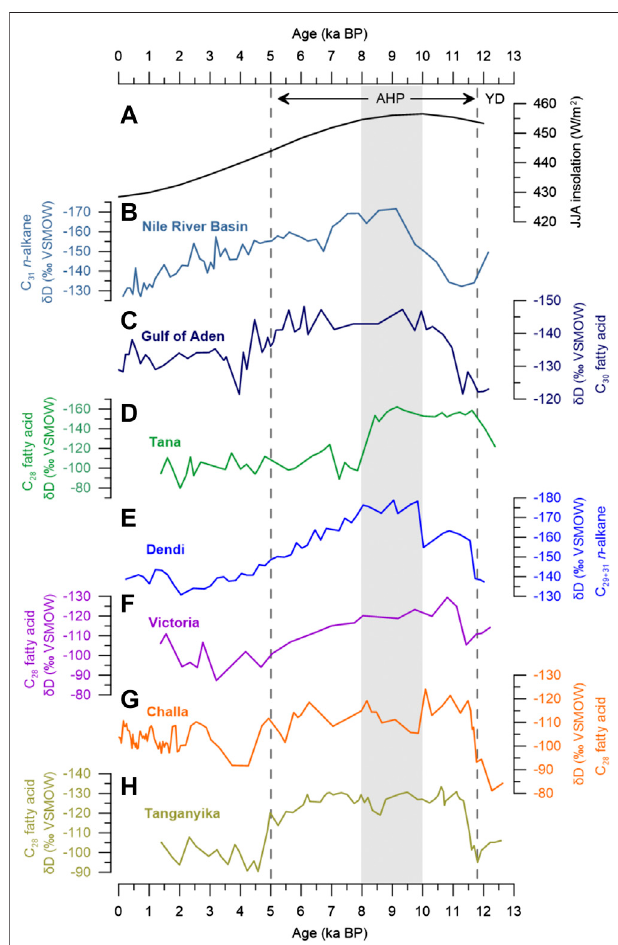
FIGURE 6 | Comparison with other East African δ D wax records. (A) Mean JJA insolation at 10 ° N (Berger and Loutre, 1991). (B) Nile River Basin (Castañeda et al., 2016). (C) Gulf of Aden (Tierney and deMenocal, 2013). (D) Lake Tana (Costa et al., 2014). (E) Lake Dendi (this study). (F) Lake Victoria (Berke et al., 2012b). (G) Lake Challa (Tierney et al., 2011). (H) Lake Tanganyika (Tierney et al., 2010). Vertical gray bar marks the optimum of the AfricanHumid Period (AHP) at Lake Dendi. Blackarrows indicate extent ofthe AHP in Africa.